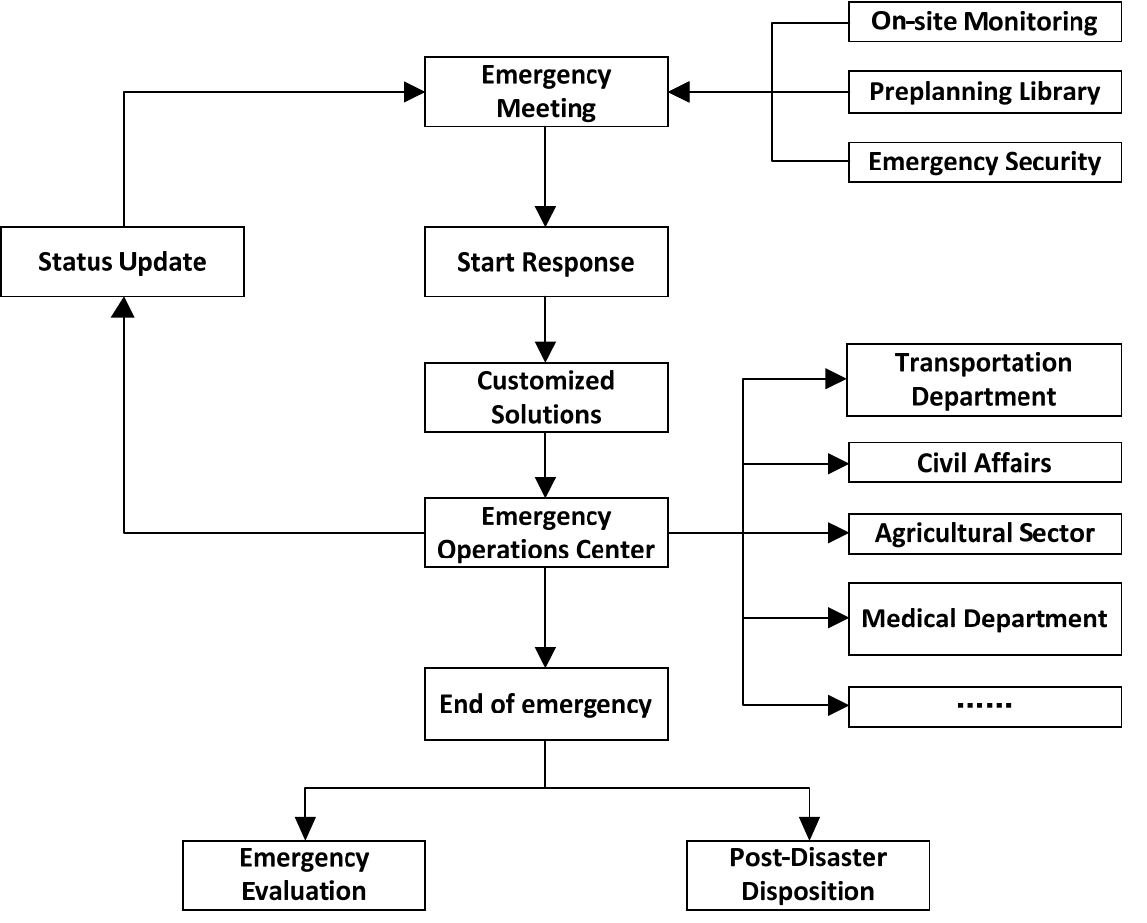
Figure 6. Modular standard disposal process.